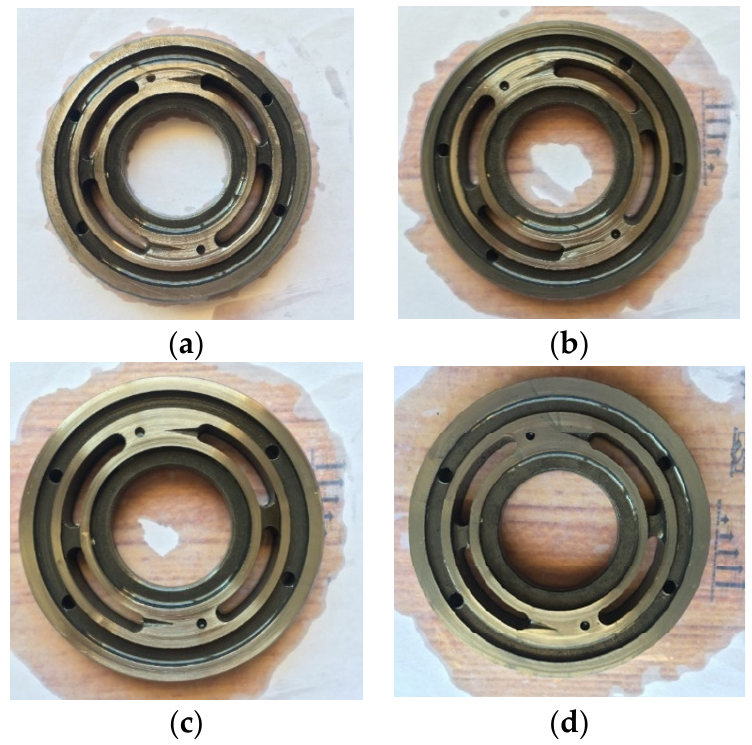
Figure 4. Valve plates under different wear states: ( a ) Zero wear; ( b ) Mild wear; ( c ) Moderate wear; ( d ) Severe wear.